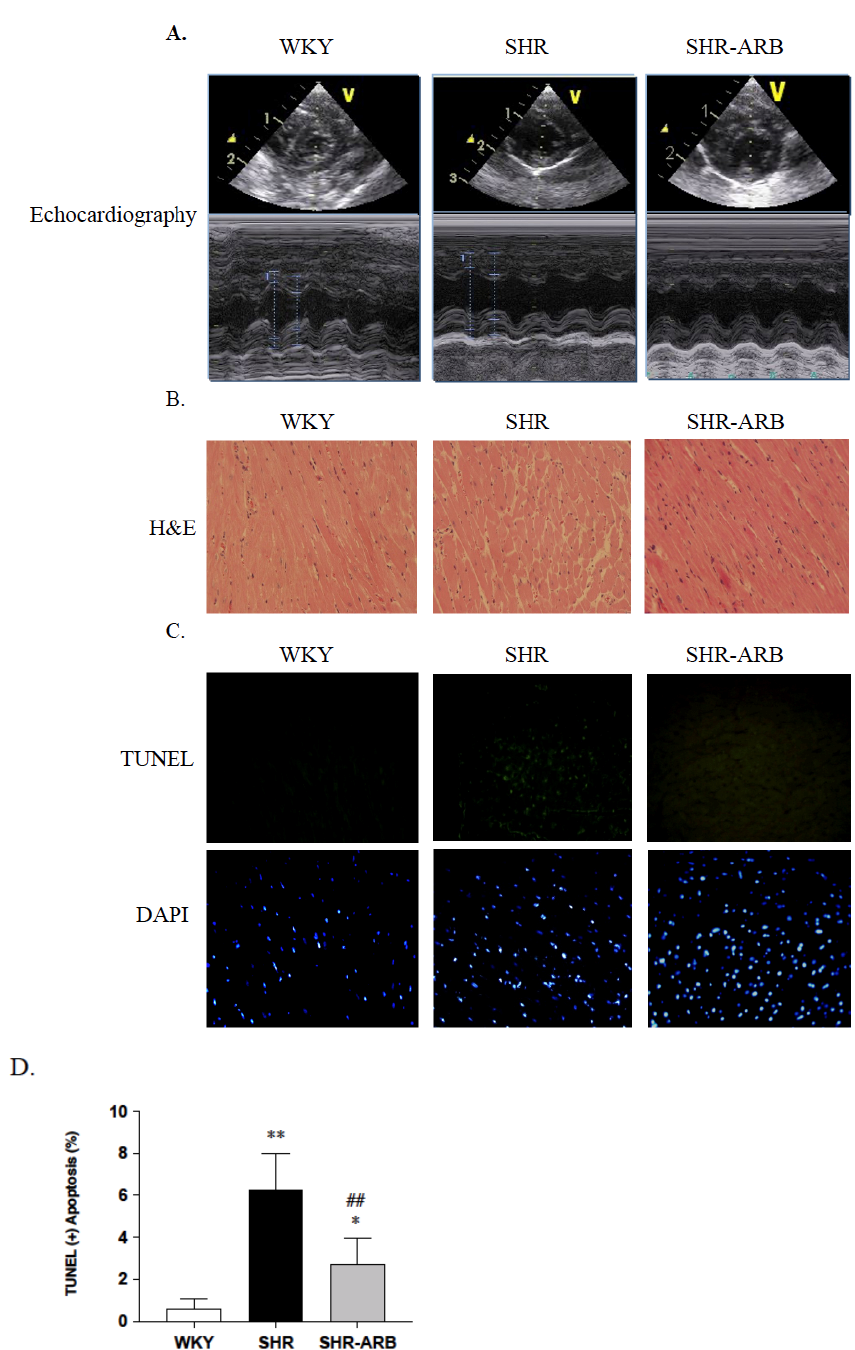
Figure 1. ( A ) Representative M-mode echocardiographic parameters were recorded through the anterior and posterior left ventricular walls and obtained with a 2D short-axis view at the level of the papillary muscles. ( B ) representative H&E (hematoxylin and eosin stain). ( C ) representative TUNEL (terminal deoxynucleotide transferase-mediated dUTP nick end labeling) assay (top: green spots) and DAPI staining (bottom: blue spots) of cardiac sections from left ventricles in the normotensive group (WKY), untreated hypertensive group (SHR), and SHR rats with treated irbesartan (SHR-ARB). The images were magnified × 400. ( D ) Bars indicate the percentage of TUNEL-positive cells and show mean ± standard deviation, (n = 6;6;6). * p < 0.05, ** p < 0.001: significant differences from the WKY group. * p < 0.05 significant differences from the Control group. ## p < 0.01 indicates significant differences between the SHR group and the SHR-ARB